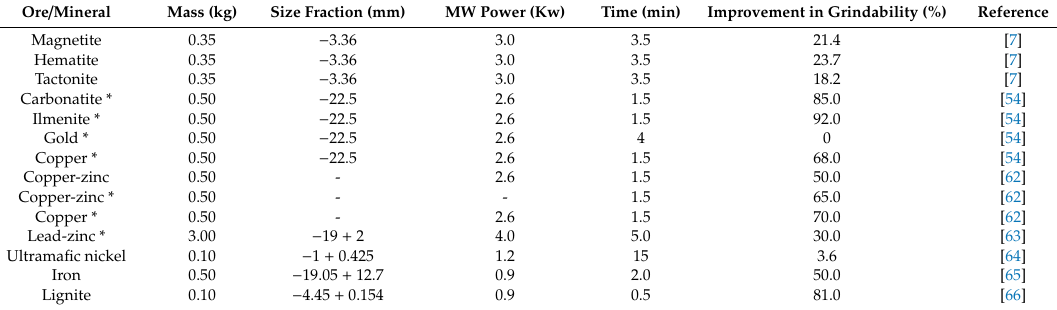
Table 2. Summary of the thermal pretreatment via microwave (MW) (frequency = 2.45 GHz) on the grindability of